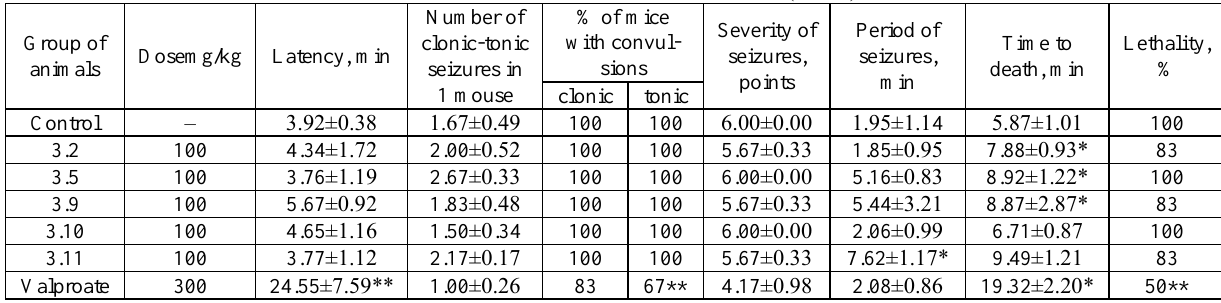
(3) in the PTZ-induced seizures in mice